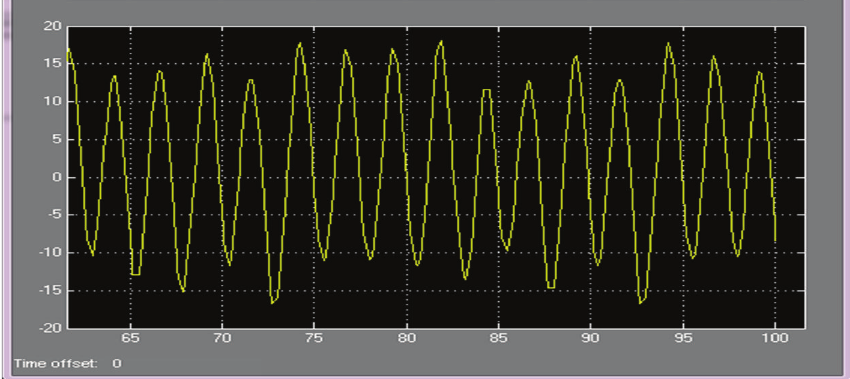
Figure 6: Existing LZ CV response to unit step change; the magnitude of controller response is shown over 100sec interval.